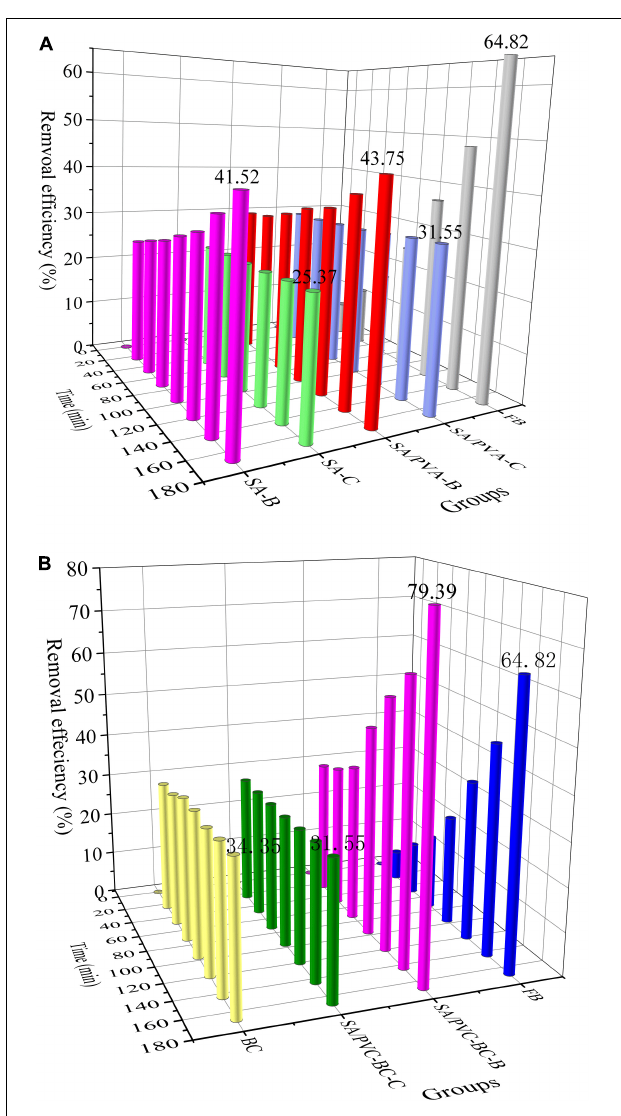
FIGURE 4 | NH 4 + -N removal efficiency by immobilized Ochrobactrum sp. (A) Comparison of immobilization methods and (B) NH 4 + -N removal efficiency by immobilization of Ochrobactrum sp. on BCCP. FB, free Ochrobactrum sp. without any immobilization methods; SA-B, SA as base material to immobilize Ochrobactrum sp.; SA-C, SA as control group without adding Ochrobactrum sp.; SA/PVA-B, SA and PVA as base material to immobilize Ochrobactrum sp.; SA/PVA-C, SA and PVA as control group without adding Ochrobactrum sp.; BC, BCCP alone for adsorption as control